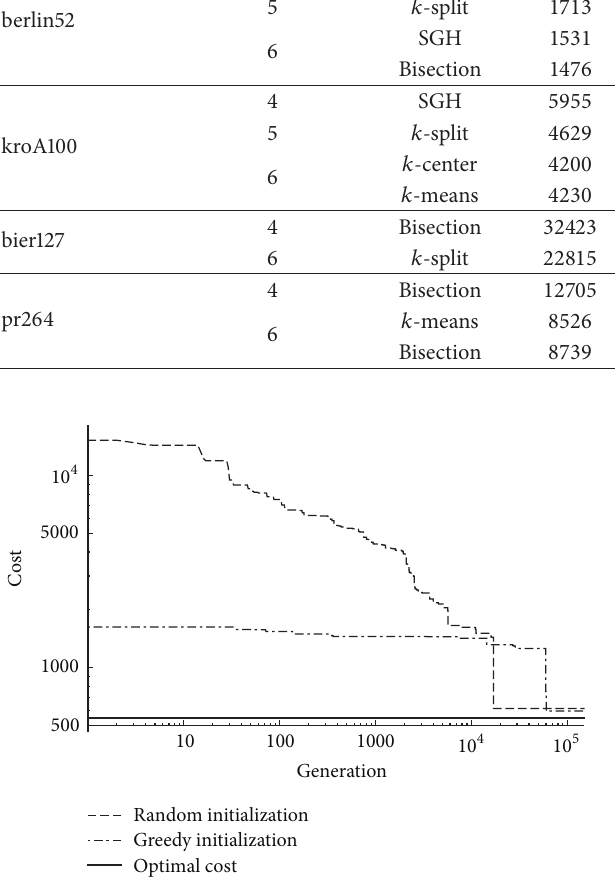
Figure 4: Convergence of the Team Plan cost for the 9-81 MAPP shown in Figure